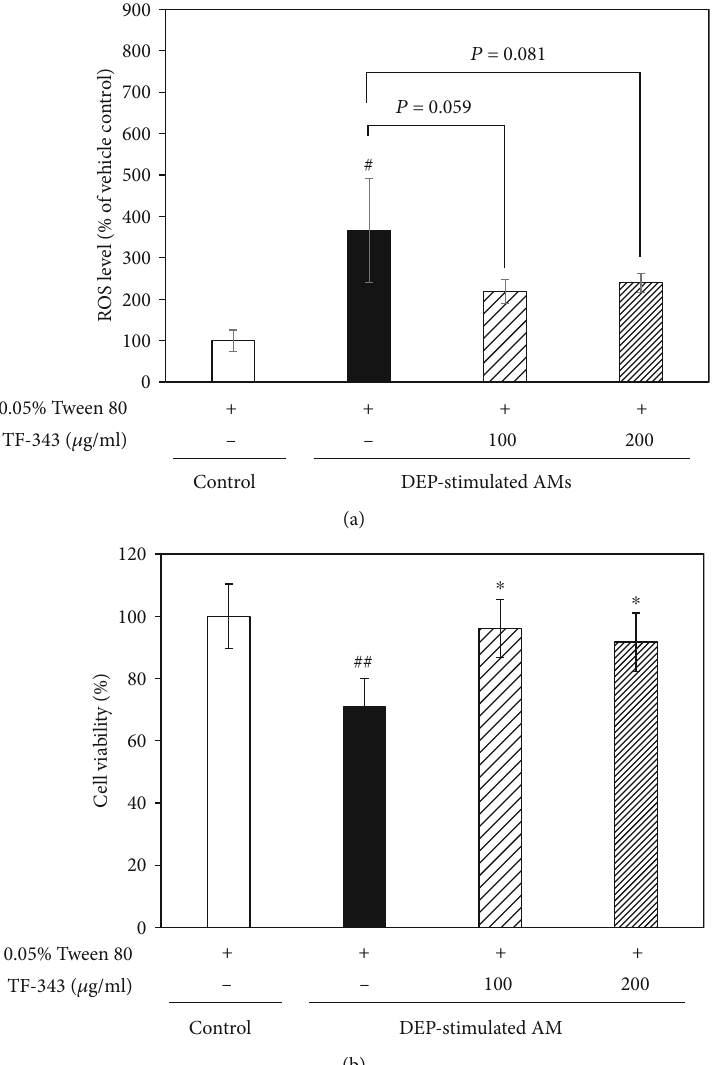
Figure 5: Intracellular ROS levels and viability of DEP-treated AMs. (a) ROS levels were measured by DCF-DA staining. Data represent mean ± SD ( n = 3 per group). # P < 0 : 05 vs. control. (b) Evaluation of cytotoxicity with the MTT assay. Data represent mean ± SD ( n = 8 per group). ## P < 0 : 01 vs. control, ∗ P < 0 : 05 vs. DEP-treated group. AMs were pretreated overnight with TF-343 (100 or 200 μ g/ml) before adding DEP (100 μ g/ml). At 3 h after DEP stimulation, DCF-DA staining and the MTT assay were